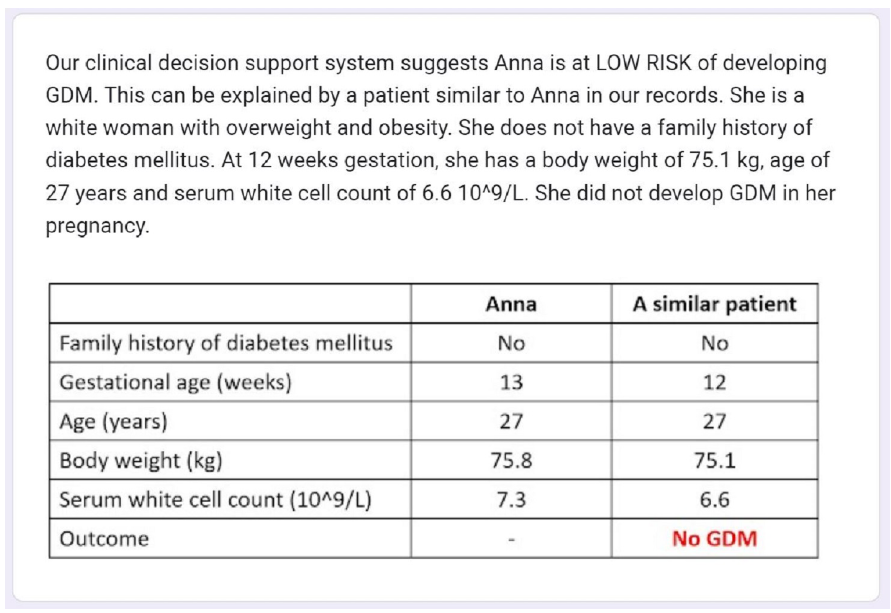
Figure 4. CDSS prediction and explanation by example for an exemplar